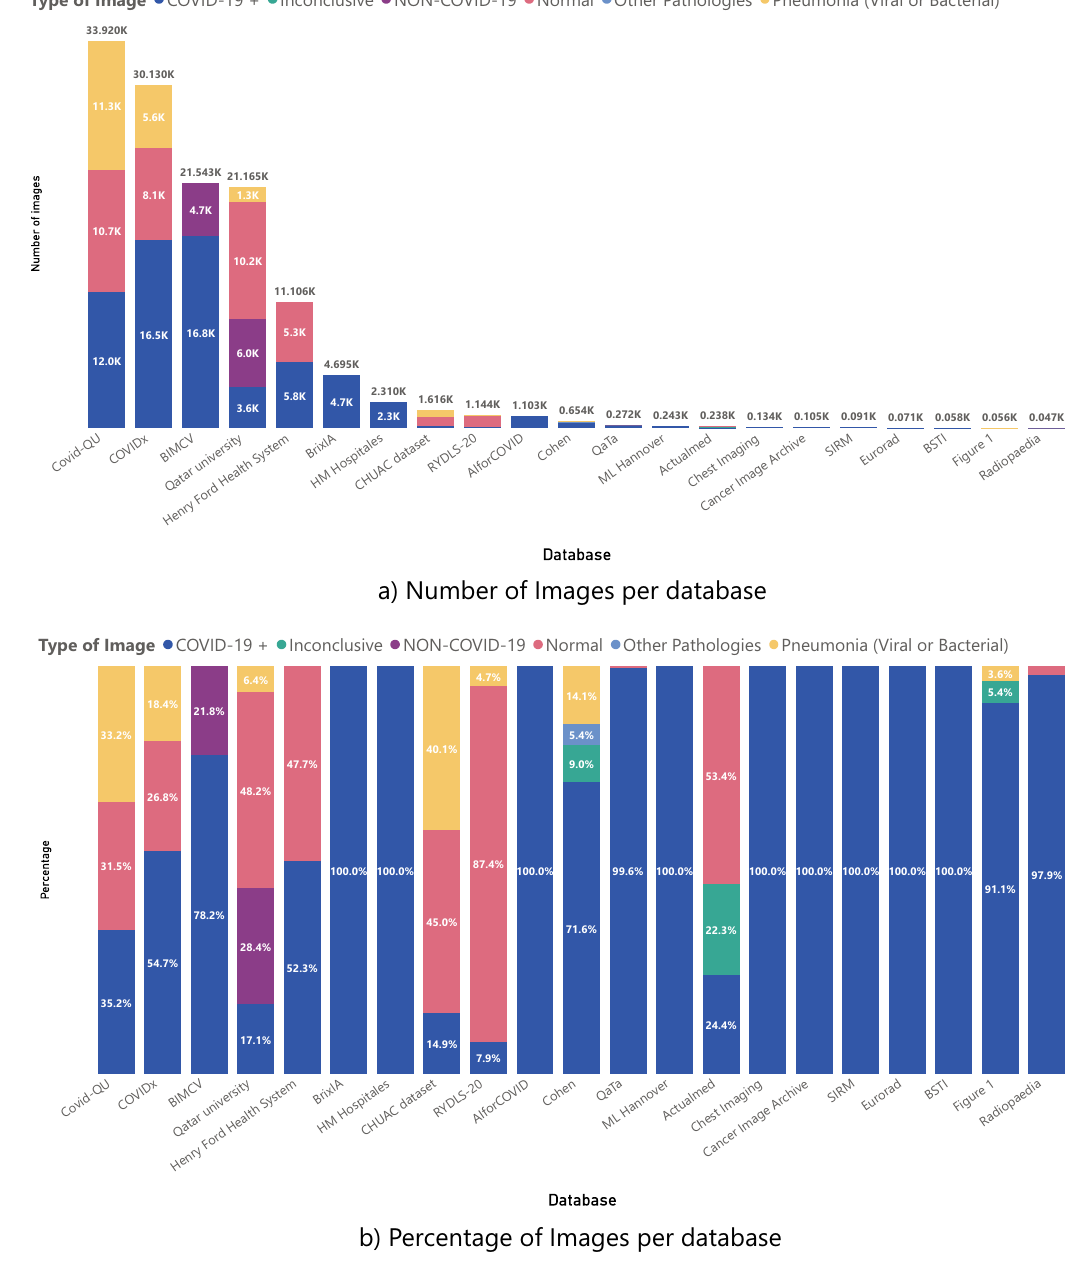
Figure 1. Number and Percentage of images according to a specific pathology on each